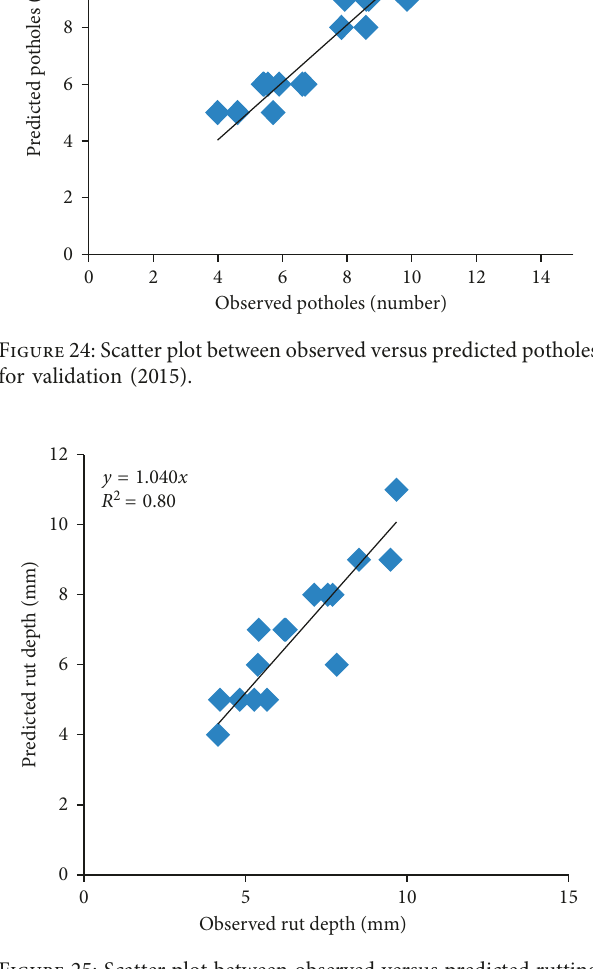
Figure 27: Scatter plot between observed versus predicted roughness for validation (0.1 IRI in ∗